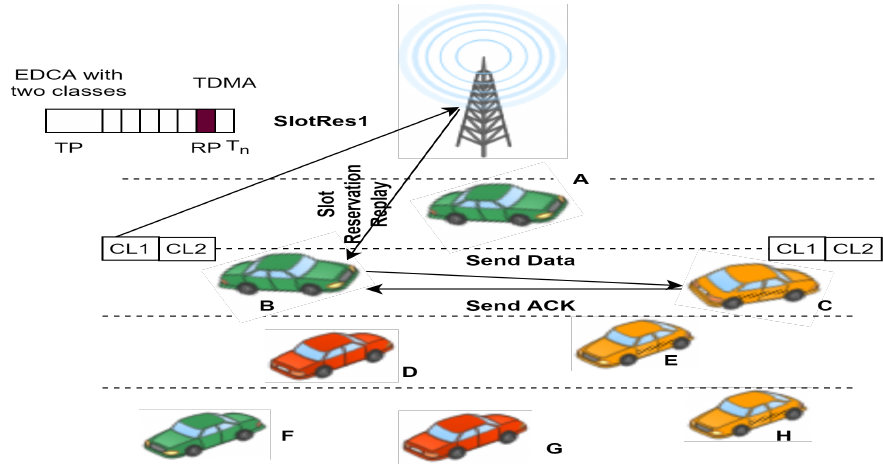
Figure 11. Access mechanism of QCH MAC